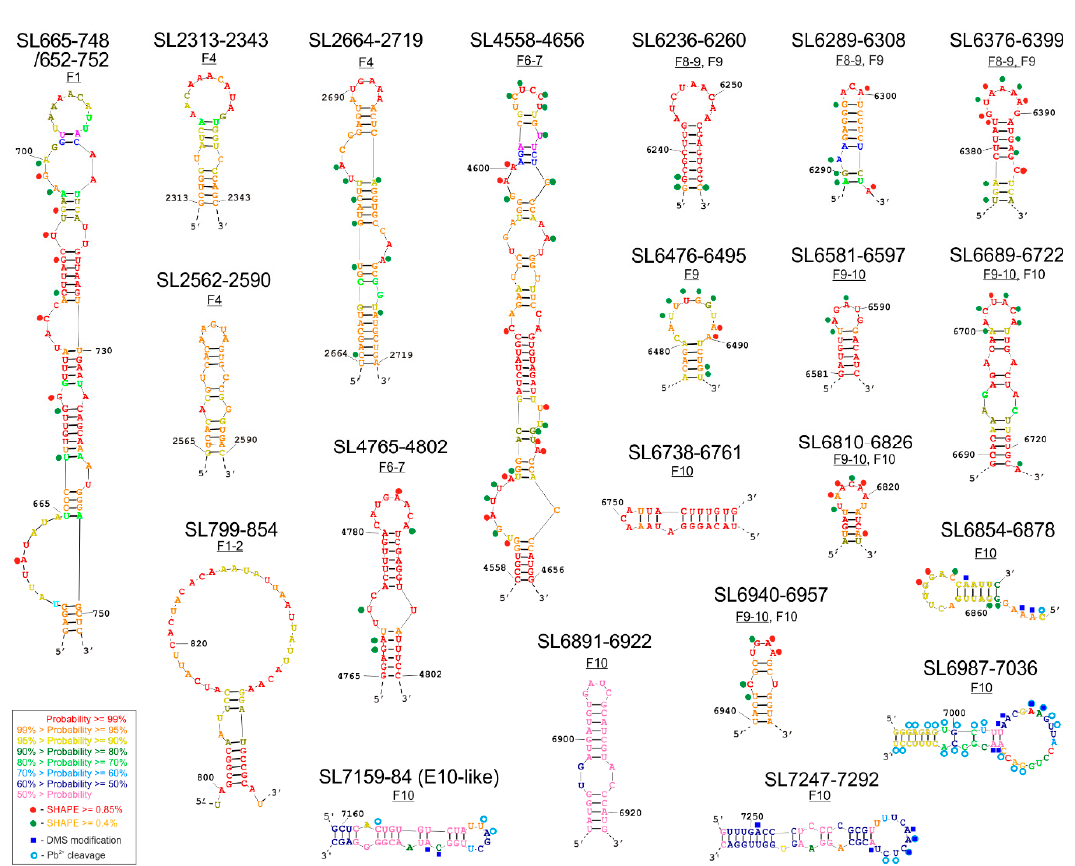
Figure 2. New RNA structural elements identified in the coding part of the Coxsackie B3 virus genome. Most probable secondary structural models of 21 new motifs with experimental mapping results depicted according to the key in the figure. The color of the letters corresponds to the probability values calculated by RNAstructure, according to the key in the figure. Motifs marked in red, orange, and yellow have the highest probability of occurrence in the analyzed RNA fragment and in the corresponding region of the viral genome, so they are considered structurally well-defined. Predicting secondary structure of partly overlapping fragments: F1 and F1–2.